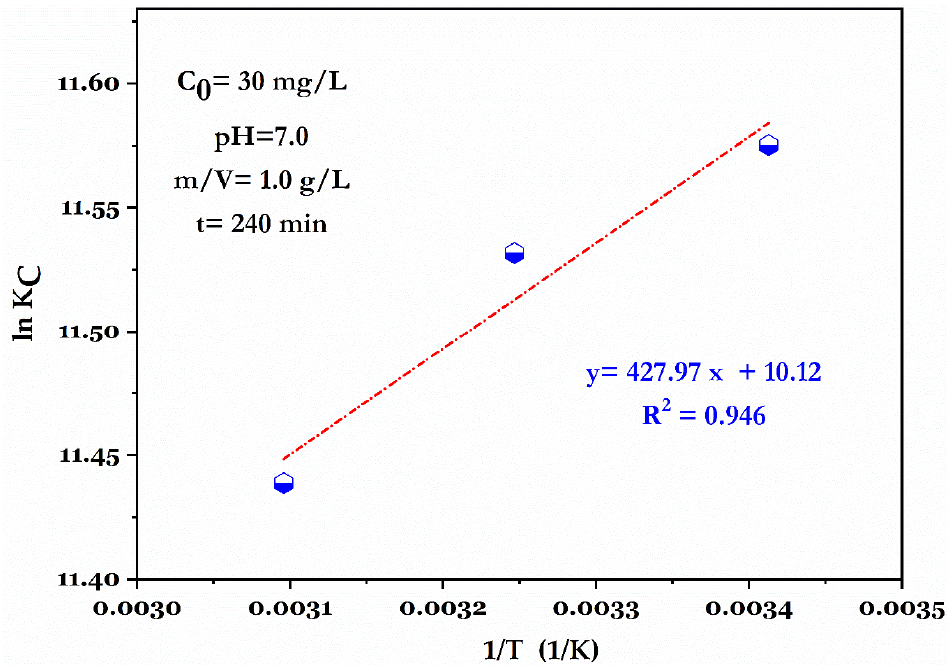
Figure 8. Thermodynamic plot for the adsorption of CV dye onto DSD adsorbent.